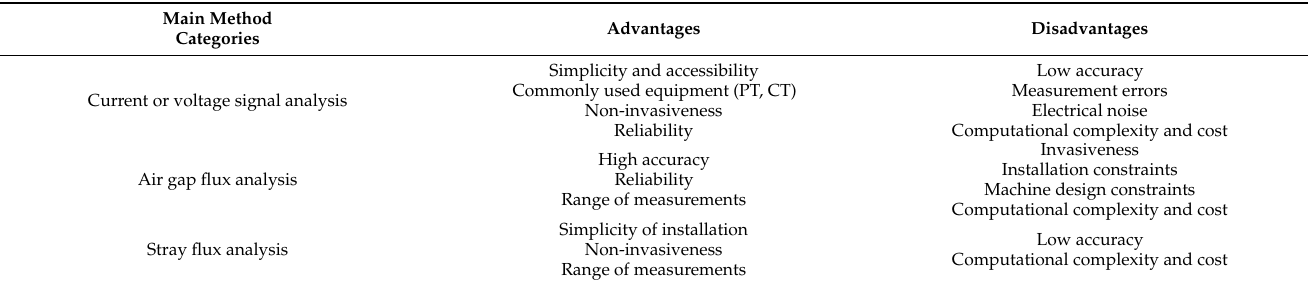
Table 1. A comparison of various online BSM field winding interturn fault detection methods.